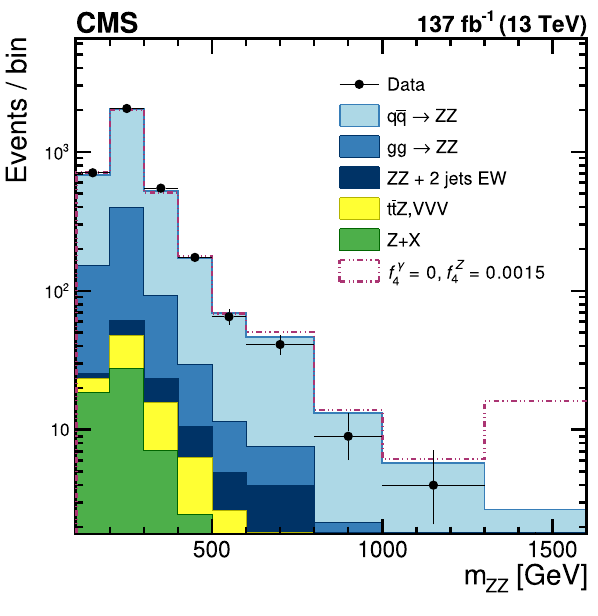
three lower panels represent the ratio of the measured cross section to the expected distributions from Matrix , powheg + mcfm and Mad- the full uncertainties calculated as the quadratic sum of the statistical and systematic uncertainties, whereas the crosses represent only the statistical uncertainties